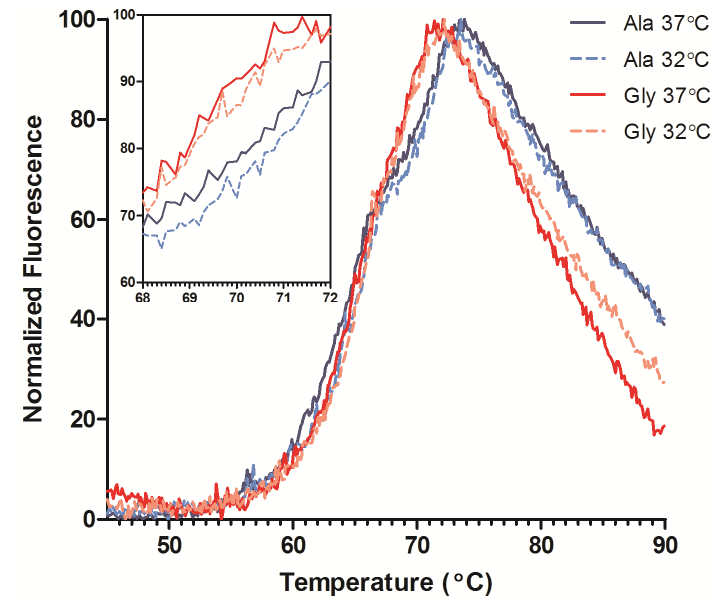
Figure 5. Differential scanning fluorimetry (DSF) profiles of purified Ala-138 and Gly-26 mAb cultured at 37 °C (solid lines) and 32 °C (dashed lines). The unfolding transitions for the C 2, C 3, and Fab domains are labeled. Each trace is the mean of four technical H H replicates. The inset graph shows detail over the Fab T